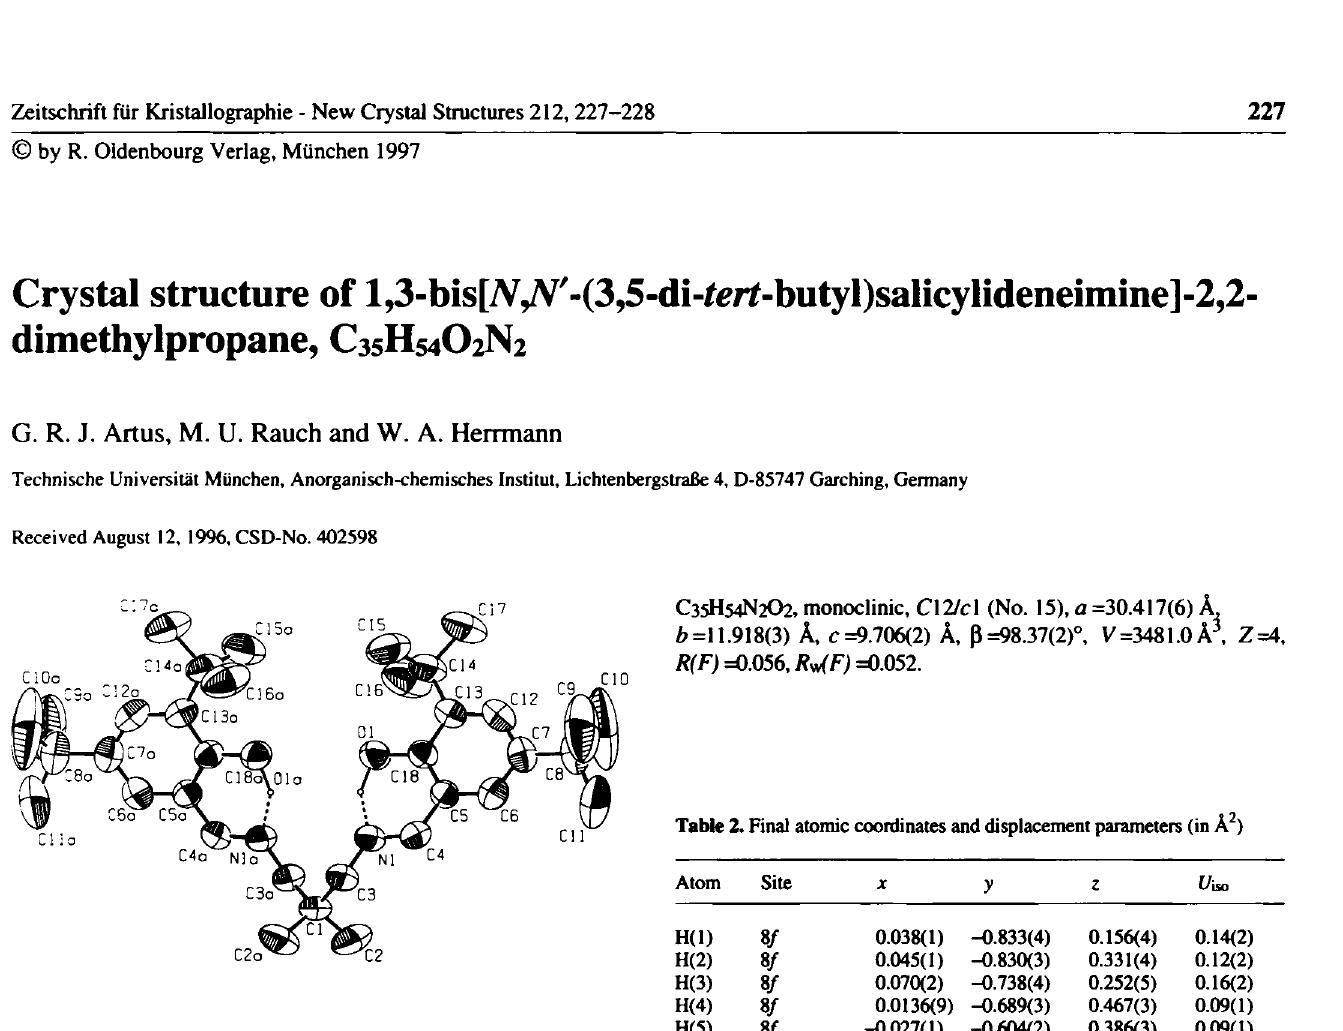
Table I. Parameters used for the X-ray data collection Crystal: